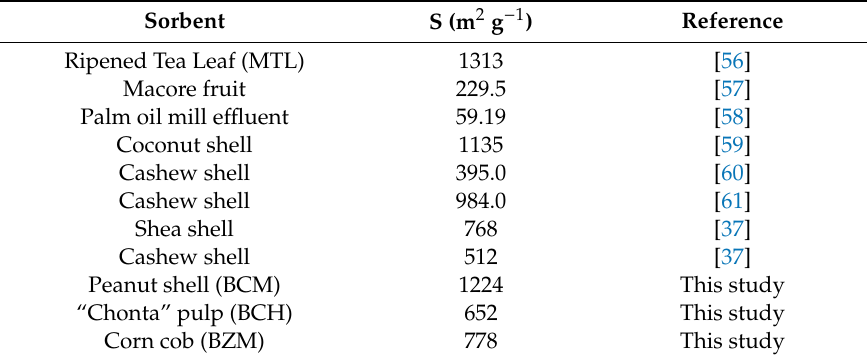
Table 2. Specific surface area of various activated carbons and